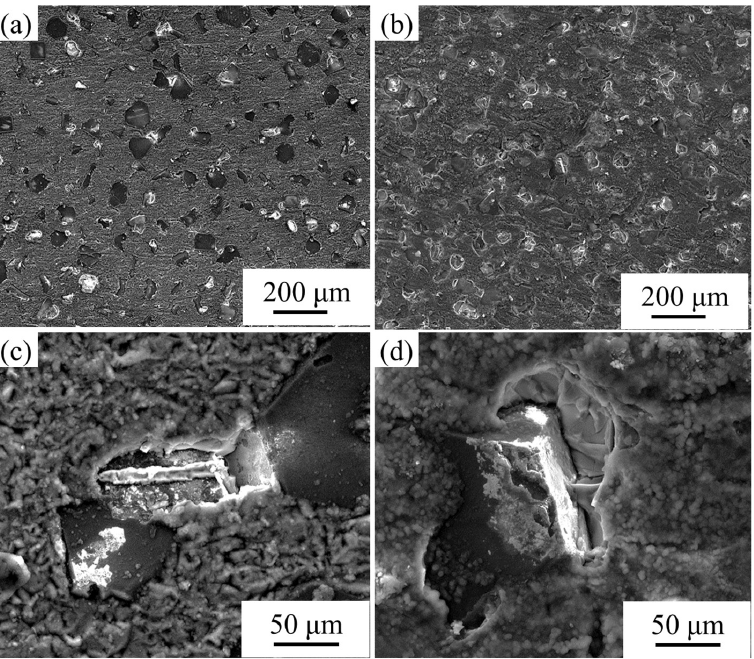
Figure 6. Surface morphology of diamond/aluminum composite after corrosion: ( a , c ) uncoated dia- mond/aluminum composite; ( b , d )W-coated diamond/aluminum